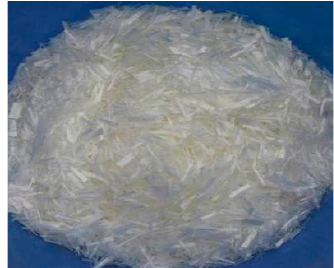
Figure 1. Short polyvinyl alcohol (PVA) fiber.